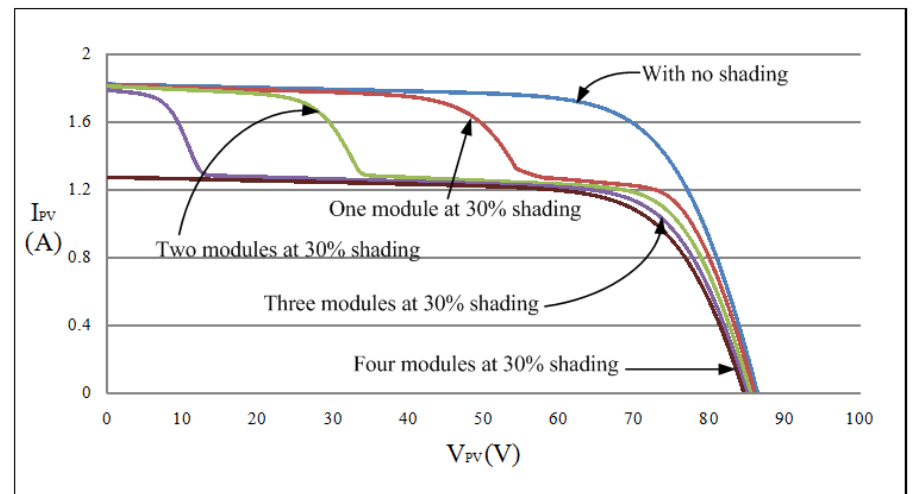
Figure 3. Simulated I–V characteristic curves of the four-serial and one-parallel array with different numbers of modules under 30% shading.